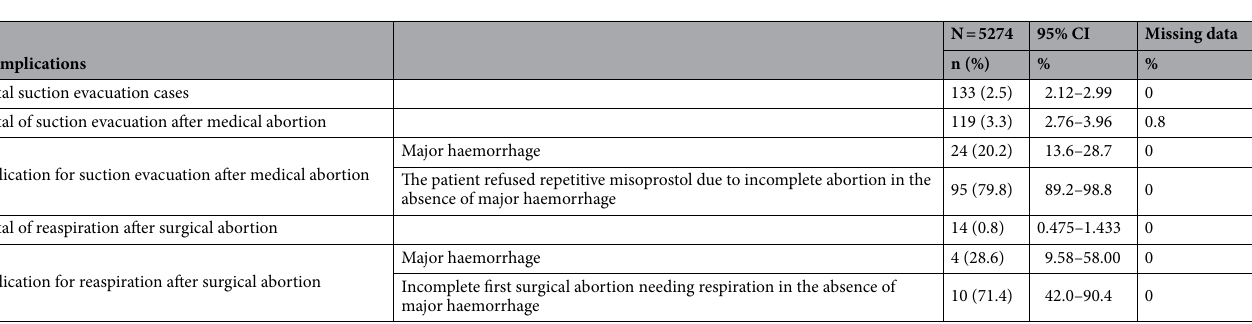
Table 4. Complications of the patients with abortion treatment by six general practitioners (GPs) between January 2008 and December 2018 in Zurich,